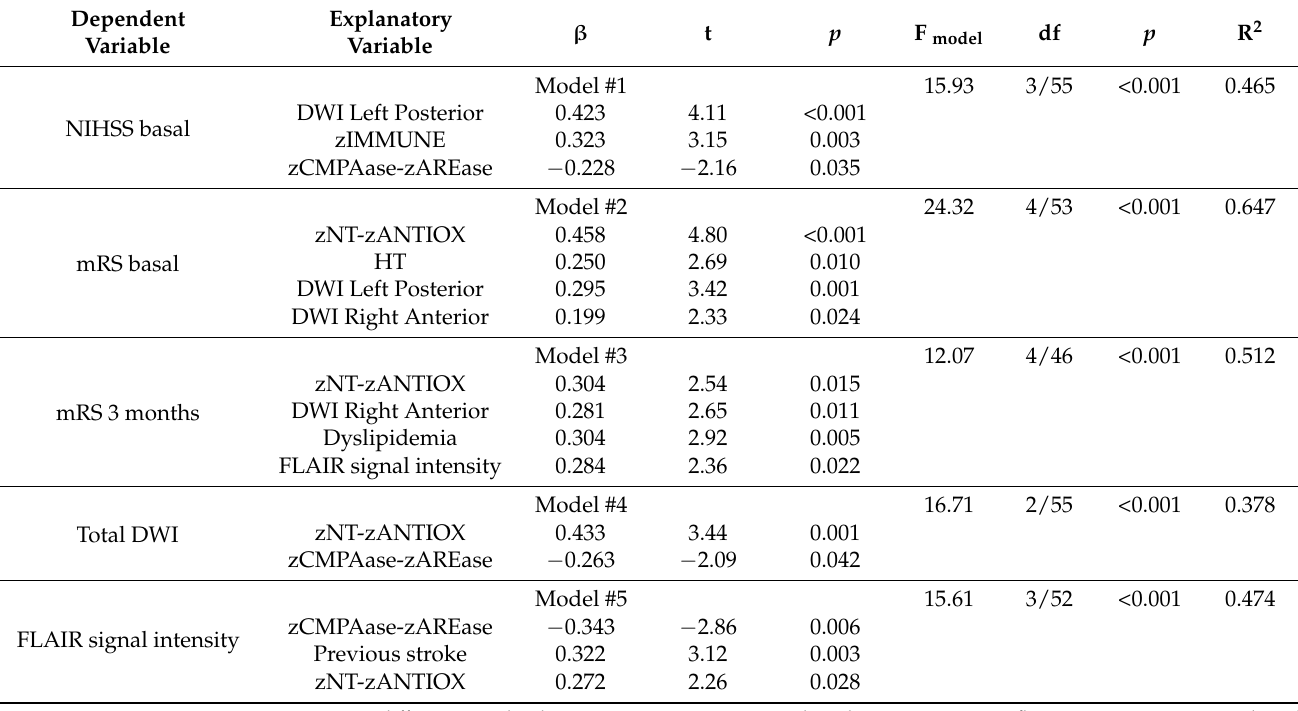
Table 6. Results of multiple regression analysis with the National Institutes of Health Stroke (NIHSS) and modified Rankin score (mRS) scores as dependent variables, and immune and oxi-dative stress composite scores and brain imaging data as explanatory